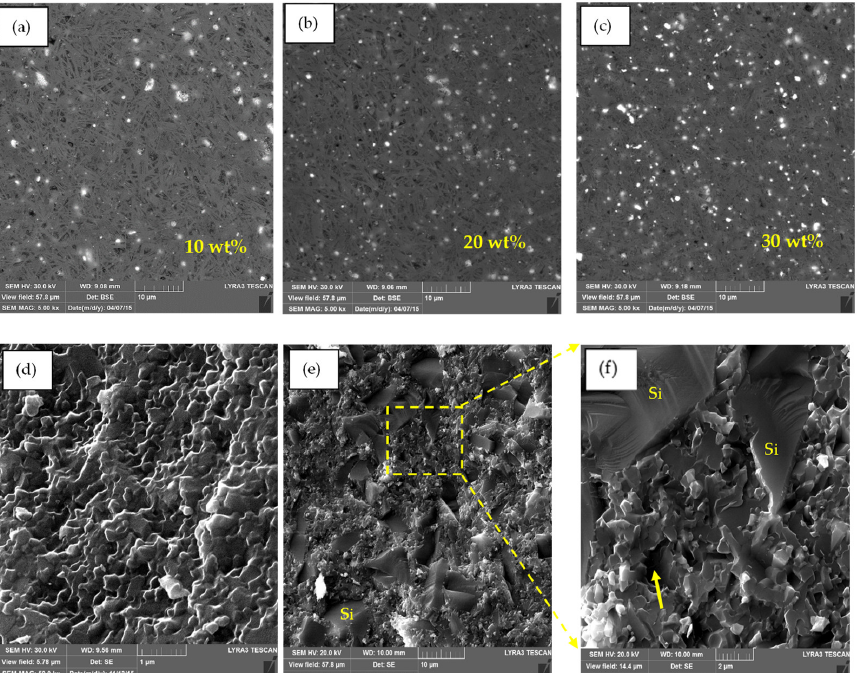
Figure 6. Polished FESEM images ( a – c ) of the Ca-α-SiAlON composites with 10 wt.%, 20 wt.%, and 30 wt.% SiC compositions, respectively (the black area shows the SiAlON matrix, and the bright dispersed phase is SiC), ( d ) FESEM image of the fracture surface morphology of the monolithic α-SiAlON, ( e ) FESEM image of 30 wt.% SiC/Ca-α-SiAlON composite ( f ) A close-up view of the image in ( e ).